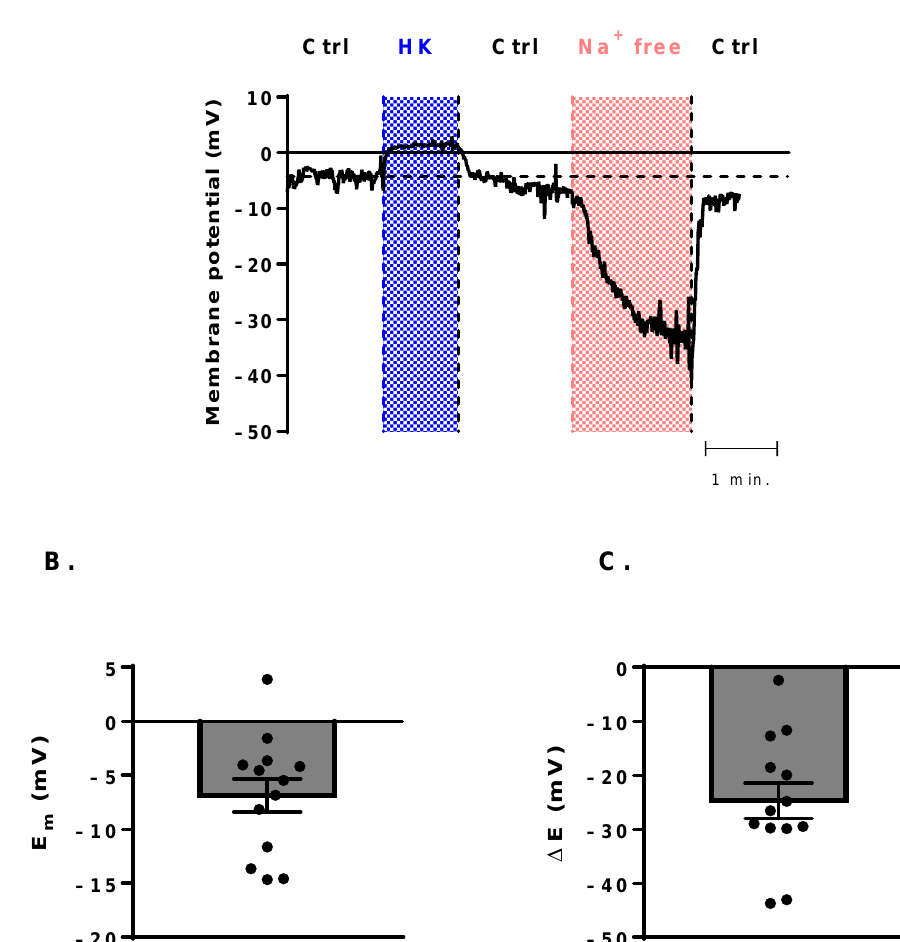
Figure 4. Membrane-potential measurements of the B cells. ( A ) The effect of the HK (blue area) and Na + -free (choline) solutions (red area) on the resting membrane potential. The horizontal dashed line indicates the resting membrane potential at the beginning of the recording, measured in control solution. ( B ) Distribution of the resting membrane potentials measured in control conditions. ( C ) Effect of Na + -free solution on the membrane potential ( ∆ E = E Na+ free − E m ). Bar heights indicate mean ± SEM, and the black symbols represent data obtained from individual